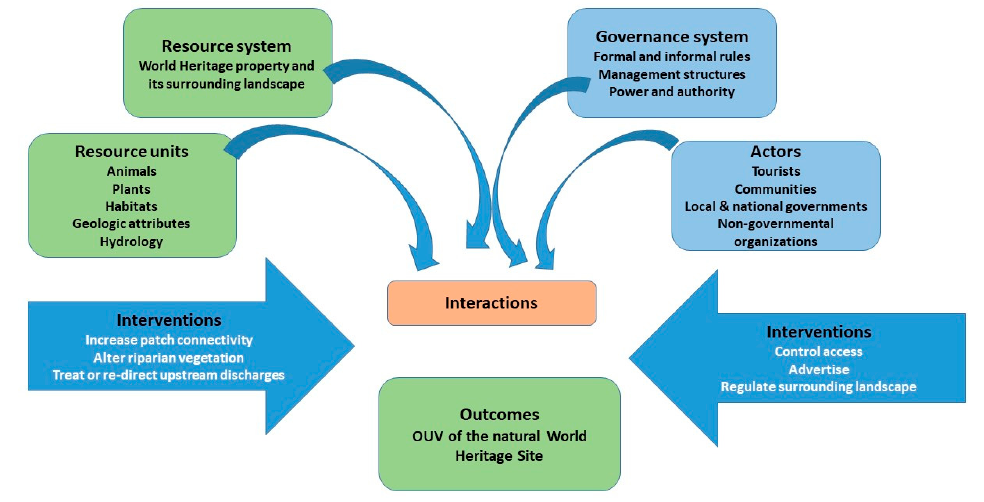
Figure 2. Biophysical and socioeconomic influences on the Outstanding Universal Value (OUV) of a NWH site, and examples of interventions as part of climate change adaptation. Modified from [47].